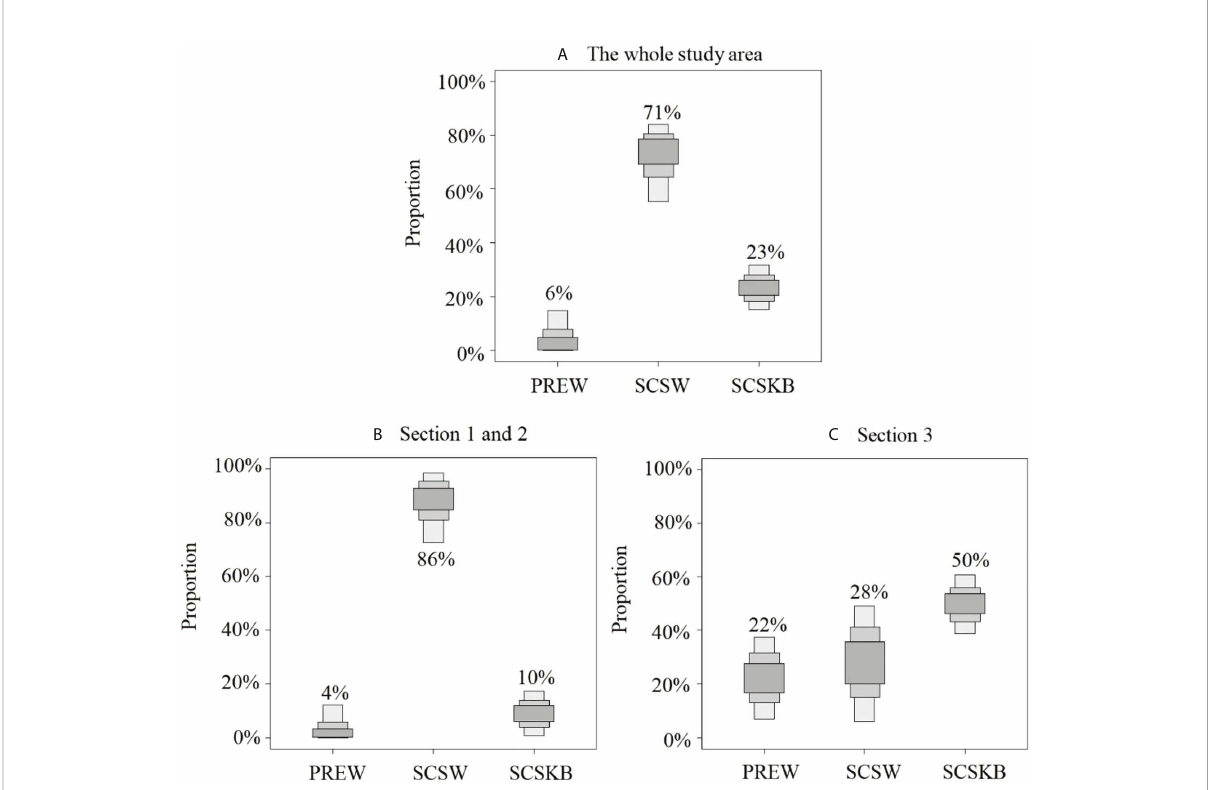
FIGURE 8 Proportional contribution of different water masses to the seawater of the PRE and the adjacent northern SCS. (A) The whole study area; (B) Section 1 and 2; (C) Section